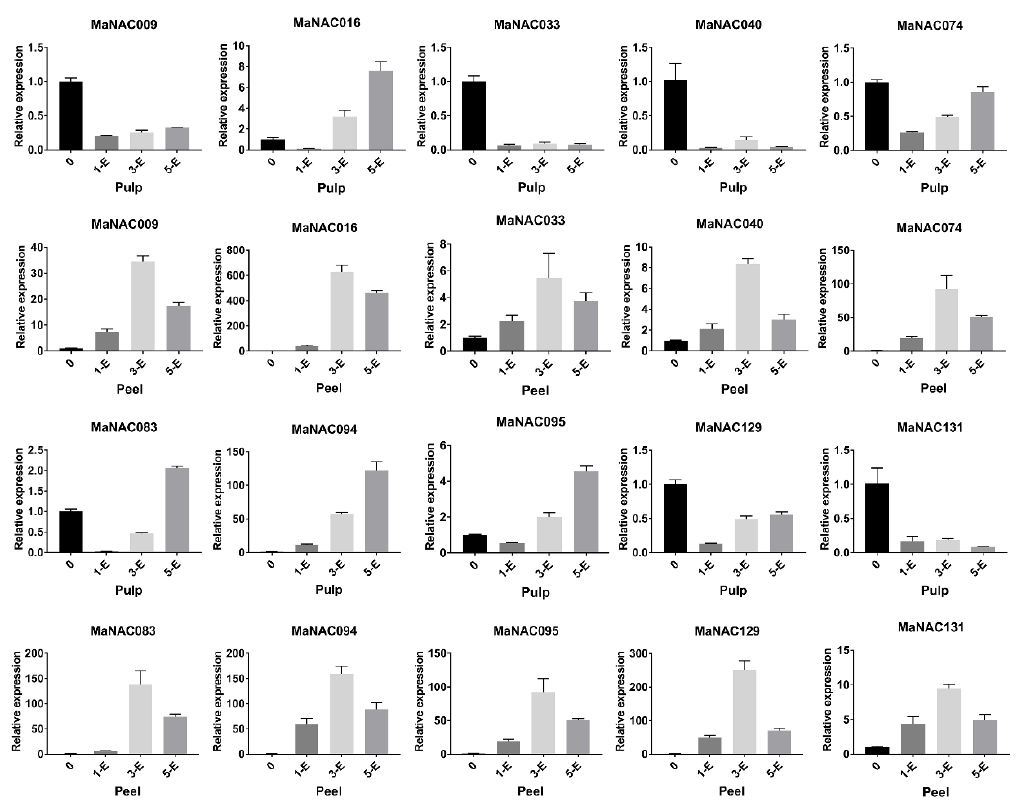
Figure 6. Relative expression of 10 selected MaNAC genes in the pulp or peel of banana at different intervals after treatment with ethylene (E represents ethylene, the number indicates the days after treatment). qRT-PCR data were normalized using the CAC gene. The name of the gene is indicated above each bar diagram. Error bars indicate the standard deviation.